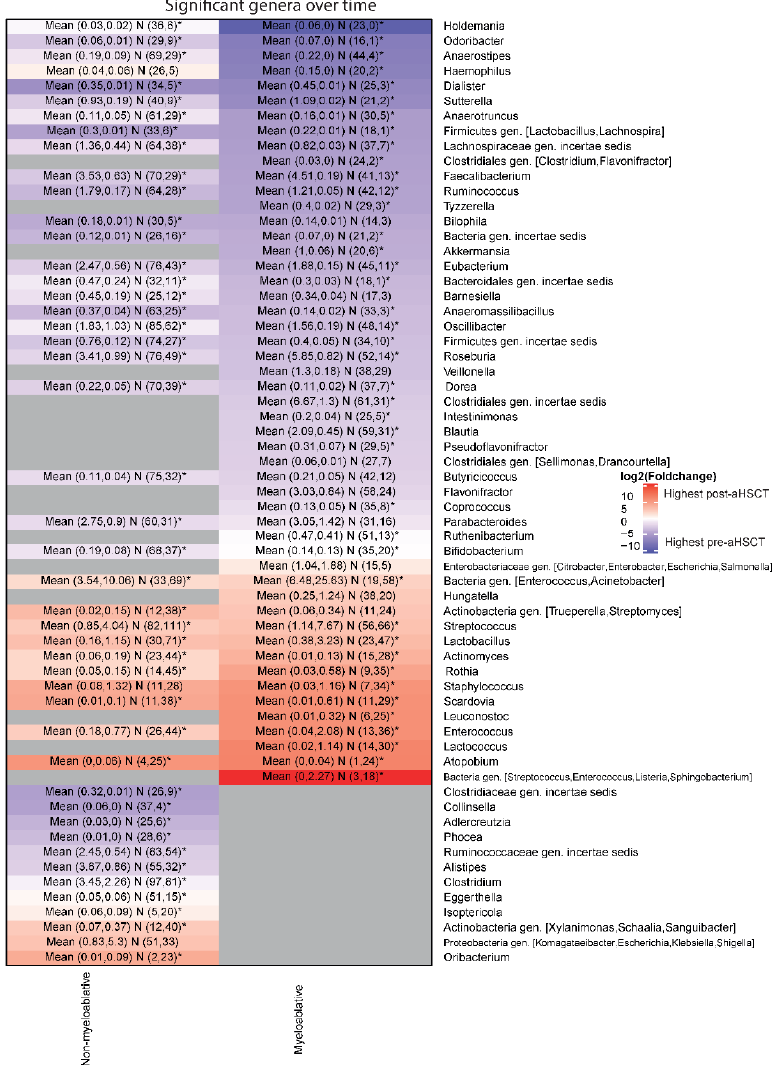
Figure 5. Associations of taxonomy with timepoints. Heatmap on genus level of the log2 fold changes between pre-aHSCT and post-aHSCT sampling period stratified by conditioning regimen. The plot shows all genera that are significantly different in at least one comparison using our discovery method. Gray means not significant. Blue colors show that the mean abundance of a genus is higher pre-aHSCT than post-aHSCT and red shows the opposite direction. The text in the cells shows “Mean (mean (pre-aHSCT), mean (post-aHSCT)) N (number of pre-aHSCT samples with the genera present, number of post-aHSCT samples with the genera present). A star indicates that the comparison is also significant in the paired analysis”. The total numbers of samples were pre- aHSCT-myeloablative = 67, pre-aHSCT-non-myeloablative = 104, post-aHSCT-myeloablative = 76, post-aHSCT-non-myeloablative =